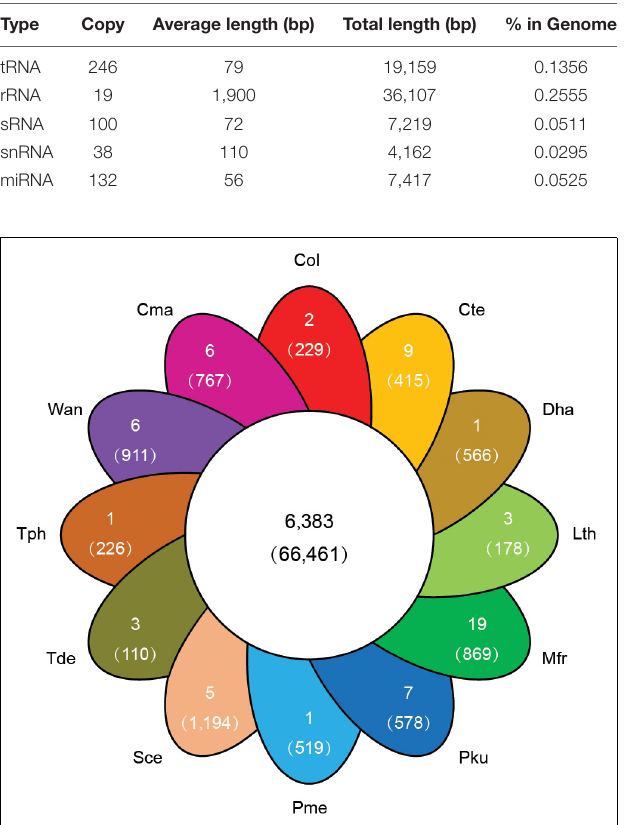
FIGURE 4 | Venn diagram indicating the number of shared and specific gene families among C. oleophila and 11 other representative yeast species. The number in the middle white circle indicates the number of shared families (no parentheses) and the number of shared genes (parentheses). In each of the colored section the number of unique gene families (no parentheses) is indicated and the number of genes within the species-specific families (parentheses) is indicated. Three-letter acronym for the abbreviation of each species.